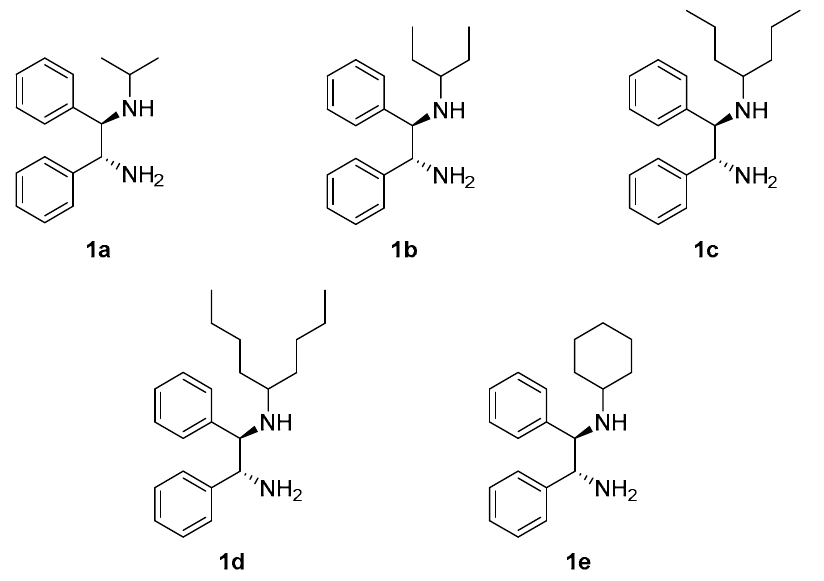
Figure 2. Chiral 1,2-diamine catalysts prepared for use in this study.